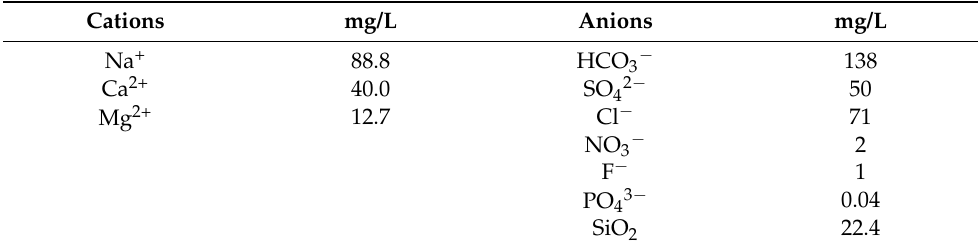
Table 1. Ion concentrations in the NSF simulated water